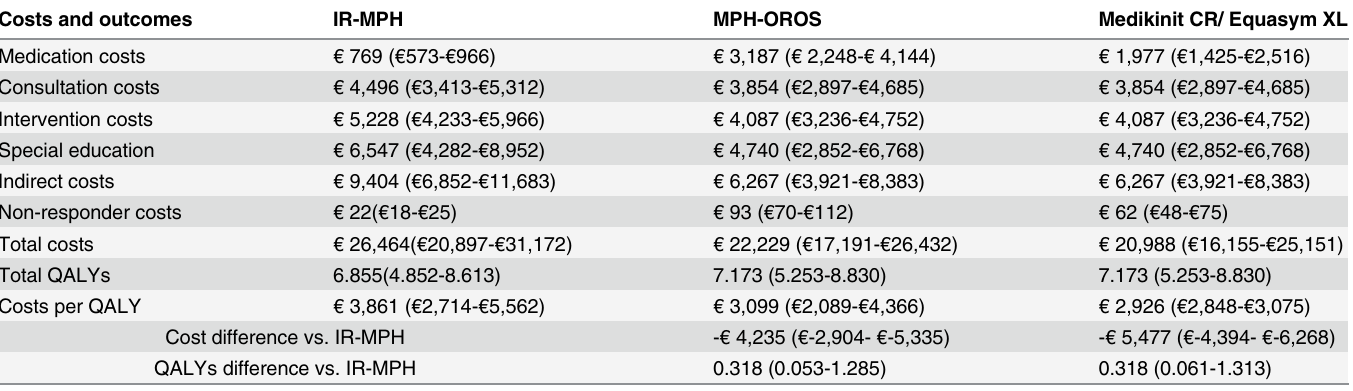
Table 1. Markov model results of base case analysis per switcher per 10